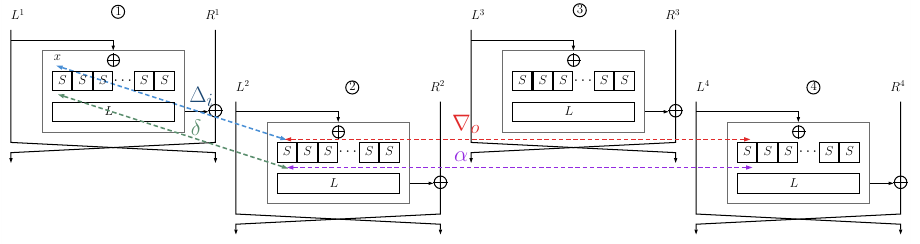
Figure 2: View of the parameters of the tables: ∆ i is the input difference and δ is the output difference of S when looking at the difference between state 1 (cid:13) and 2 (cid:13) . ∇ o is the input difference of the same S-box S when looking at the difference between state 1 (cid:13) and 3 (cid:13) and α is its output difference. We focus on the case where the differences are the same on parallel